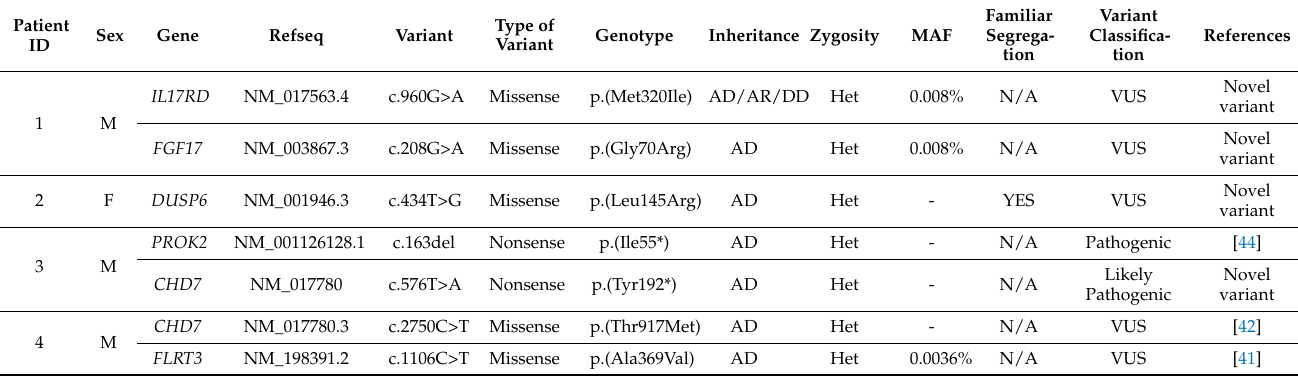
Table 2. Clinical and biochemical features of the patients with